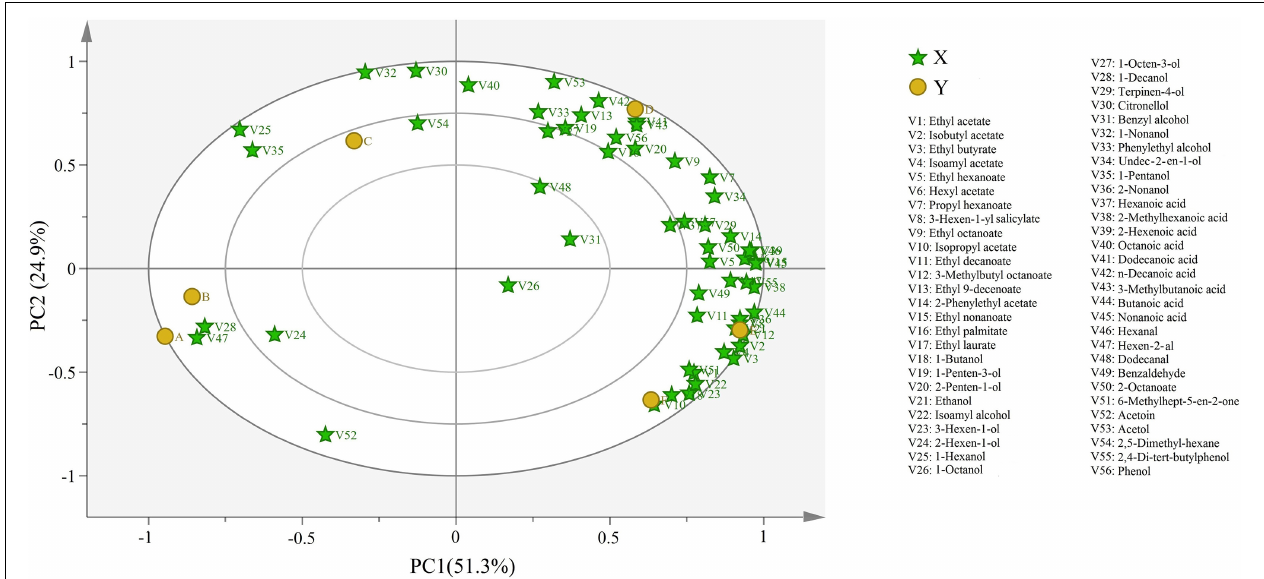
FIGURE 3 | Bioplot of PCA for volatile compound of wine samples. A, B, C, D, E, and F represented samples collected on fermentation days 0, 1, 4, 7, 11, and 14,